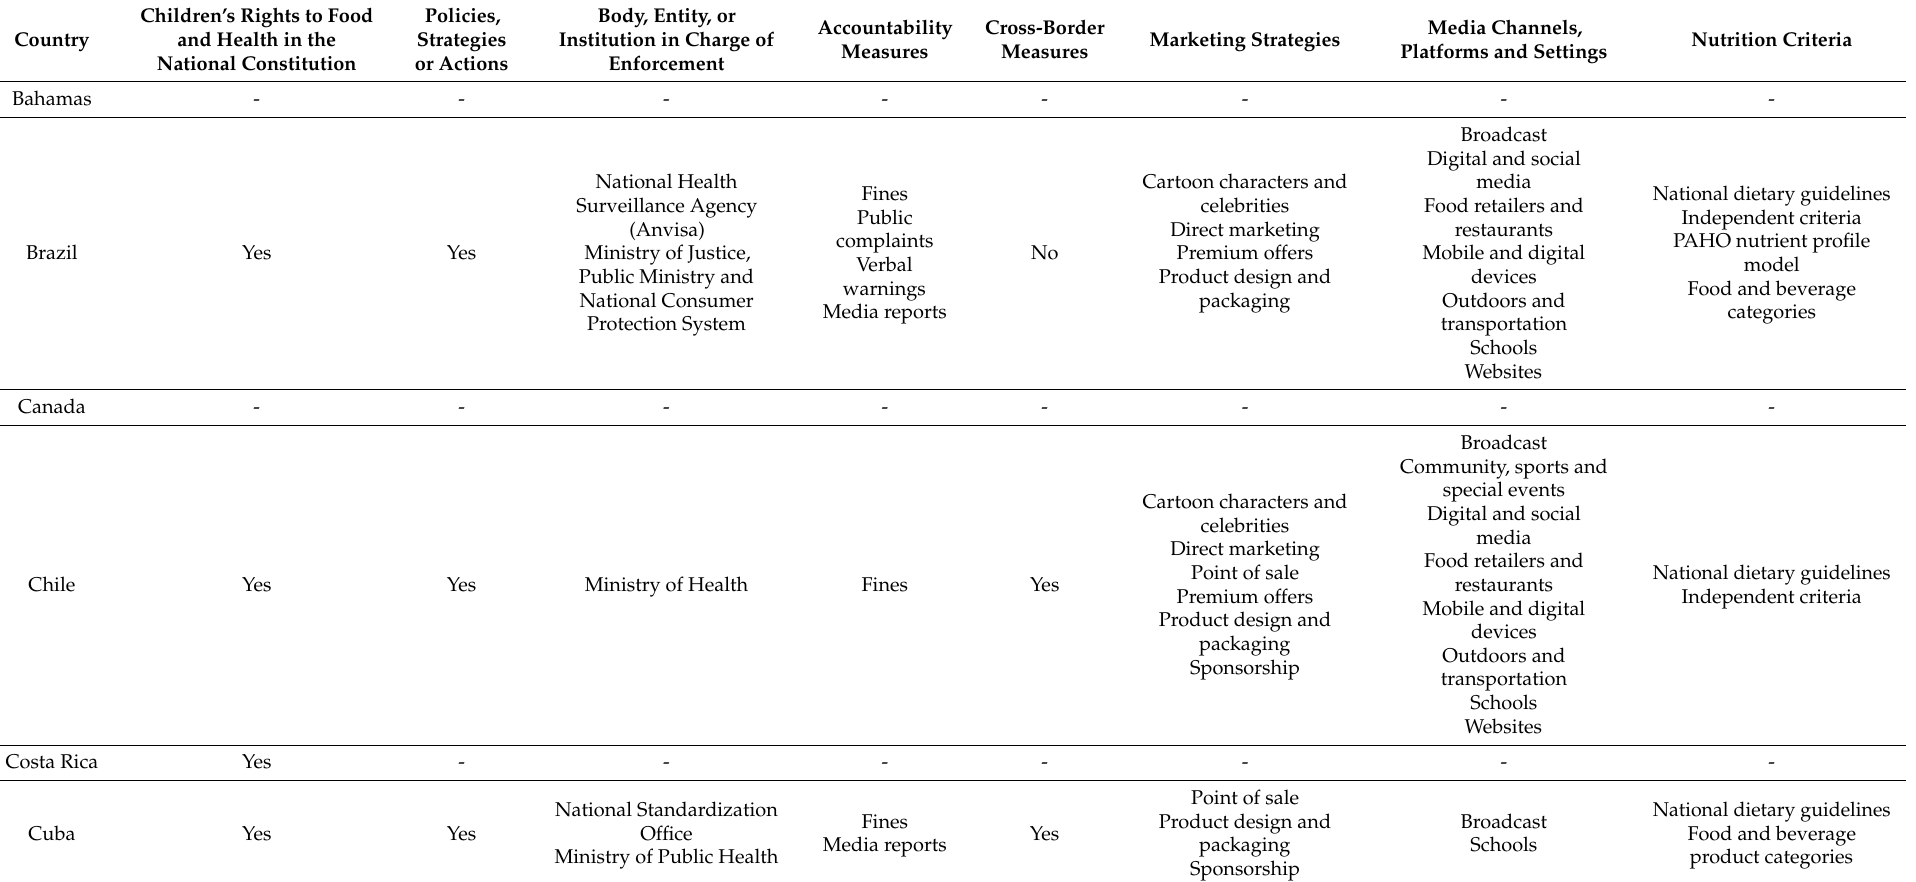
Table 2. Capacity-building policy efforts to restrict the marketing of HFSS food and non-alcoholic beverages in countries in the region of the Americas.